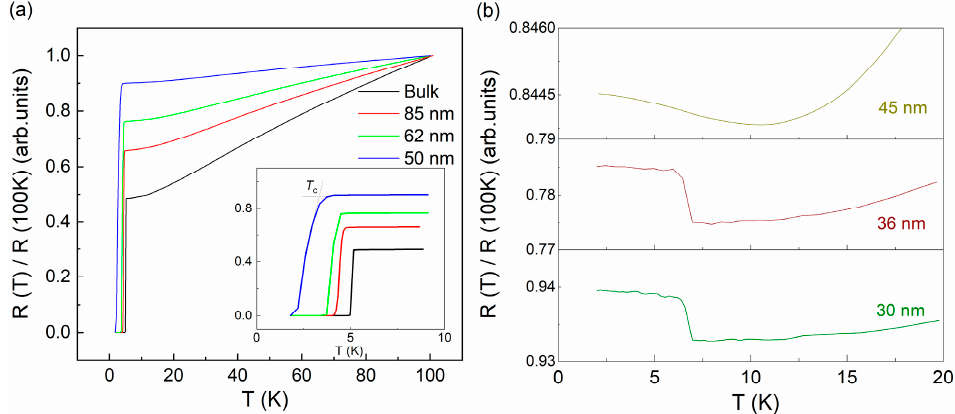
Figure 2. ( a ) and ( b ) Temperature dependence of normalized resistance, R(T)/R (100 K) for a series of β -PdBi 2 nanoflakes with different thickness. The inset of ( a ) is a close-up of the curves near the T c .